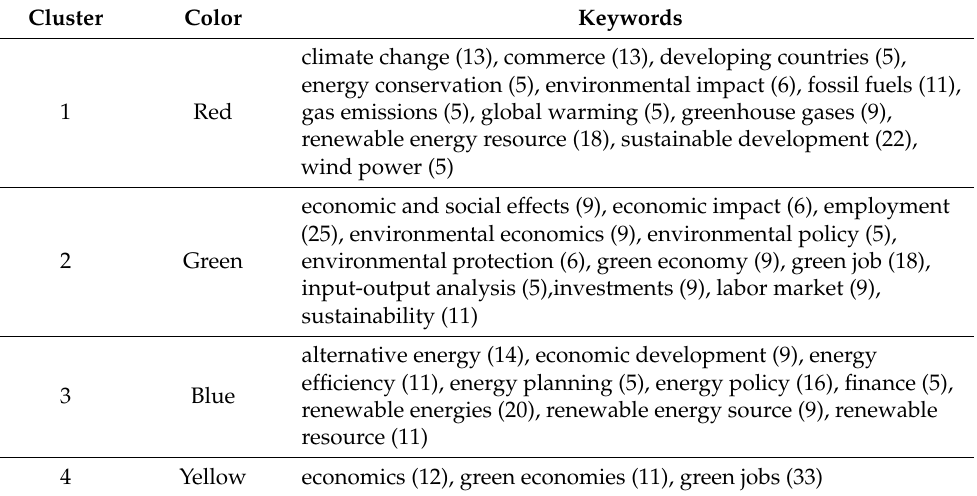
Table 3. Clusters of keyword co-occurrences visible in Figure 3.